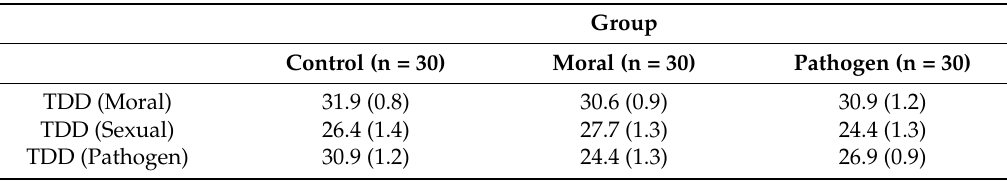
Table 2. Mean (SE) Disgust Sensitivity (TDD) (Experiment